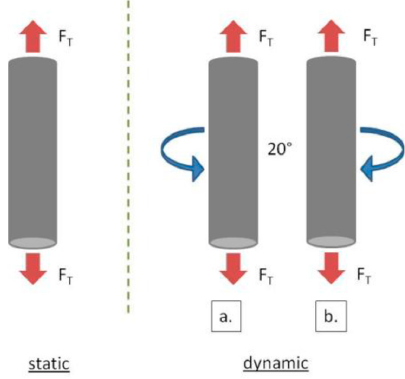
Figure 6. Schematic image of the two types of mechanical movements (F T —traction strength).